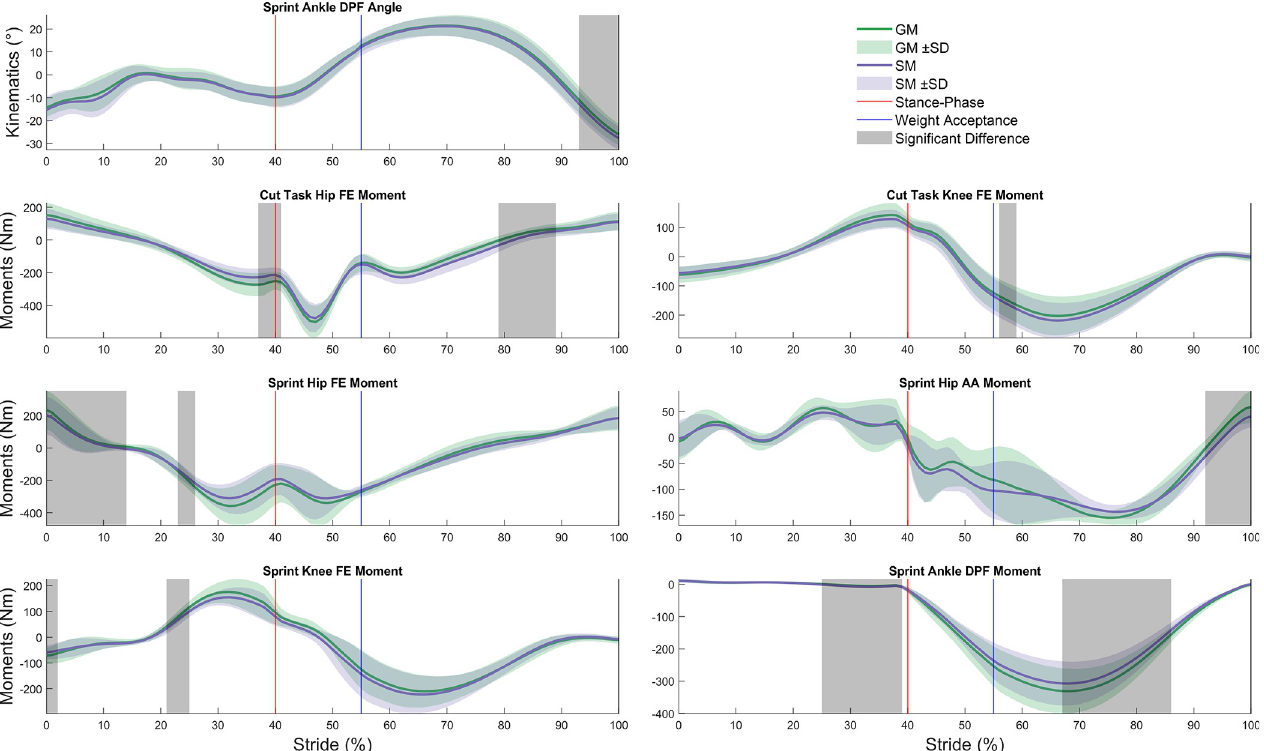
Fig 2. Significant joint angle and moment differences between generic and subject-specific models. FE, flexion/extension; AA, adduction/abduction; DPF, dorsi/plantar flexion; Generic model (GM), subject-specific model (SM), and respective variation between participants as standard deviation. Foot ground contact of the stance limb depicted as the red line. End of weight acceptance phase depicted as the blue line. Areas of significant difference, as determined by statistical parametric mapping (grey).